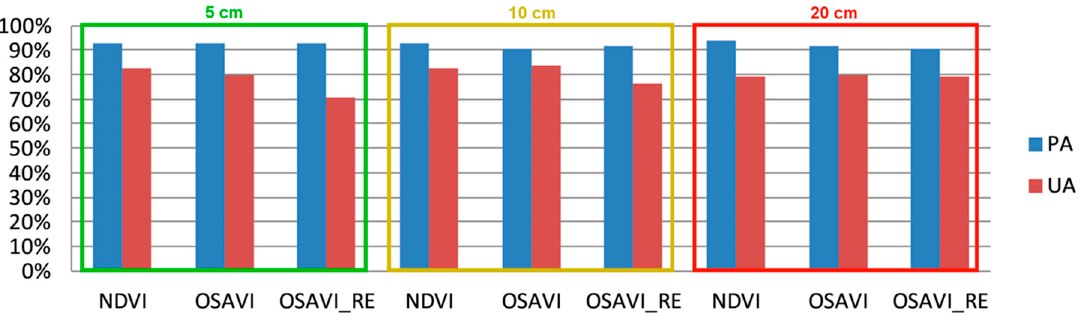
Figure 13. Producer’s (PA) and user’s (UA) accuracy of results without the influence of roads, with three different approaches performed on 10 cm input data.